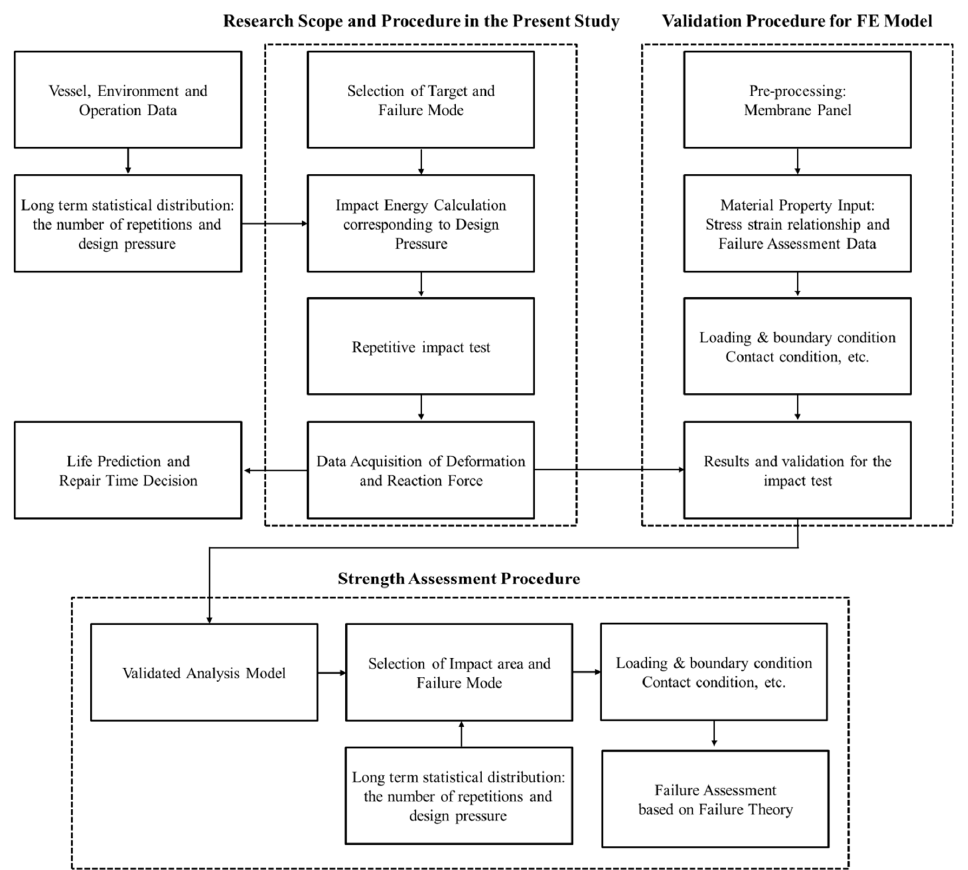
Figure 15. Research process for liquefied natural gas cargo (LNGC) structure member that includes research scope performed in this